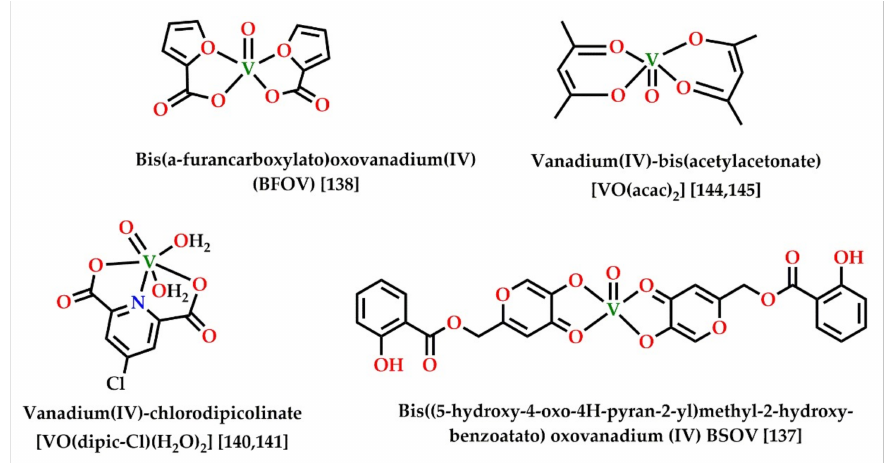
Figure 7. Structures of some vanadium (IV) complexes with reported AMPK activation activity. Table 3. Vanadium compounds with reported AMPK phosphorylation and activation activity.